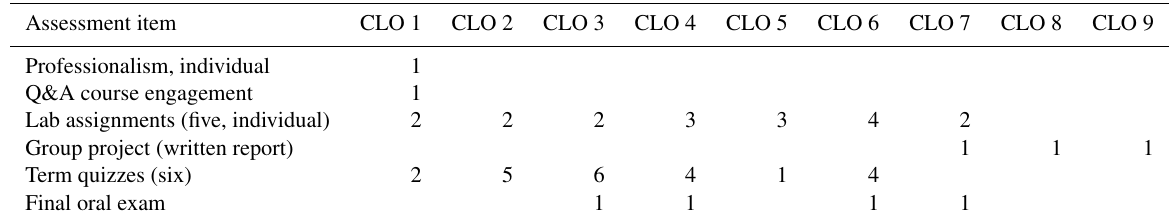
Figure 10. Grade distributions of (a–b) a geological map and section completion question within a lab assignment in fall 2019 (in person) and fall 2020 (remote). (c–d) The Lighthouse Bay Virtual Mapping Assignment in fall 2020 (remote) and fall 2021 (in person). Table 4. CLO distribution in GEOE/L 221 assessments in fall